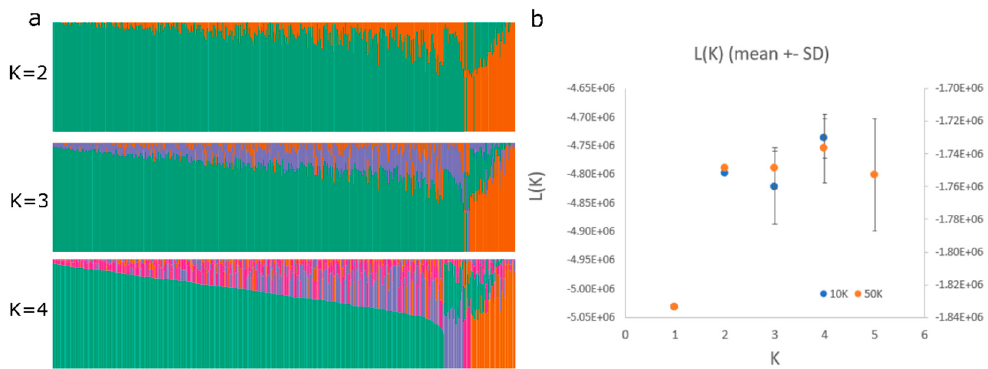
Figure 4. Population structure of the diversity panel population as determined using STRUCTURE for 5 different K values with a sub-population of markers representing one marker every 50,000 bases. Admixture set at <40%. ( a ). The K vs. Ln Likelihood plot is also shown for two different marker sets with one marker every 10,000 bases and every 50,000 bases, the most likely K value being 2 − 4 with the 1 marker / 50,000-base dataset ( b ).